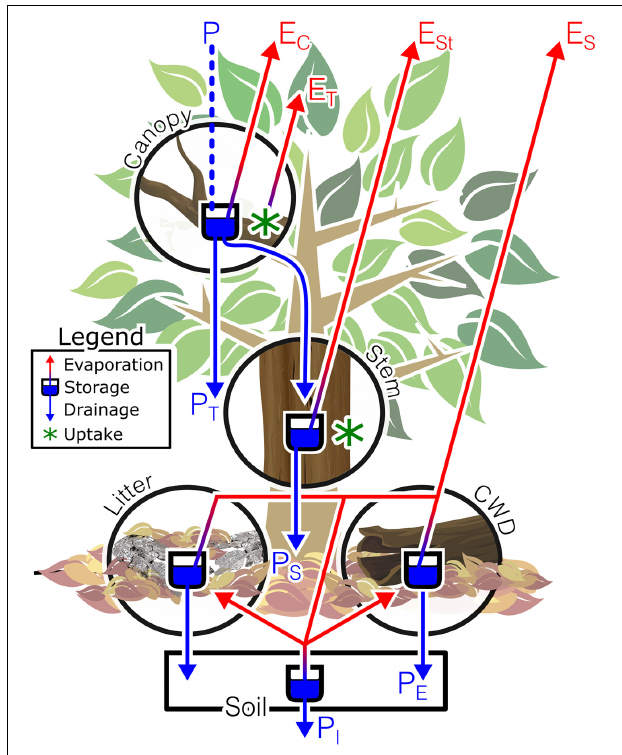
FIGURE 2 | The forest water cycle and opportunities for bark-water interactions. Incoming precipitation (P) can be stored and evaporated at various points, from the bark on the canopy (E C ), stem (E St ) and in the litter (including coarse woody debris, CWD), and soil surface (E S ). In the canopy and on the stem, bark-water interactions can result in uptake and a portion of this uptaken water may be transpired (E T ). Precipitation will also interact with canopy bark as it drains as throughfall (P T ), stemflow (P S ); litter bark and CWD before becoming effective precipitation (P E ) and infiltration (P I